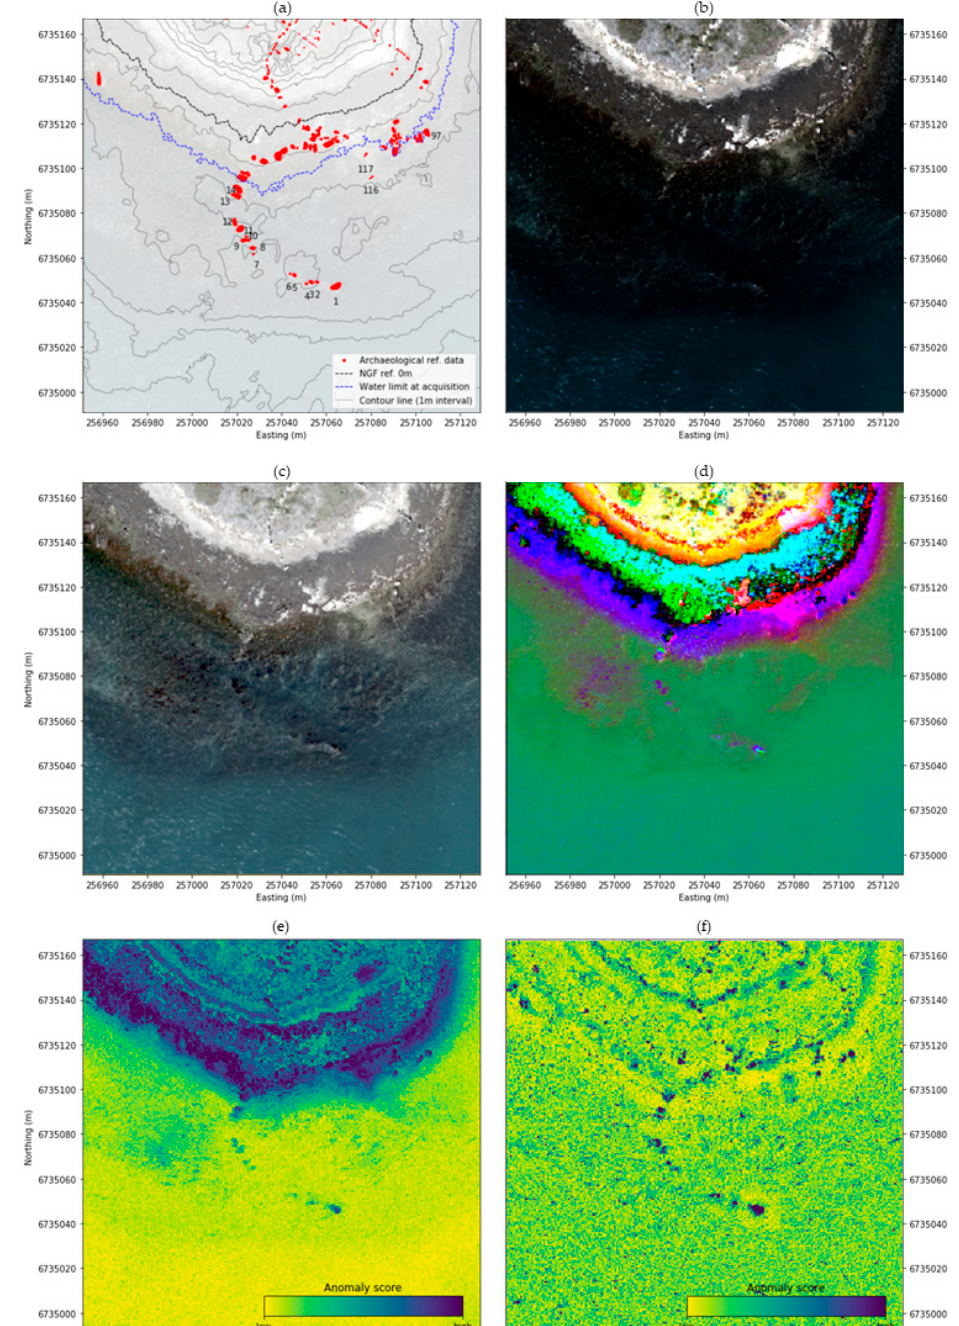
Figure 6. ( a ) Archaeological reference map of the study site (submerged steles are numbered). True-color (RGB) images simulated from hyperspectral data and spectral sensitivity functions ( b ) without and ( c ) with gamma correction ( γ =0.4). ( d ) Minimum noise fraction pseudo-color image with bands Red=9, Green=3 and Blue=4. ( e ) Anomaly score calculated using the Isolation Forest (IF) algorithm. ( f ) Anomaly score calculated using the local Reed–Xiaoli detector (LRXD) algorithm.